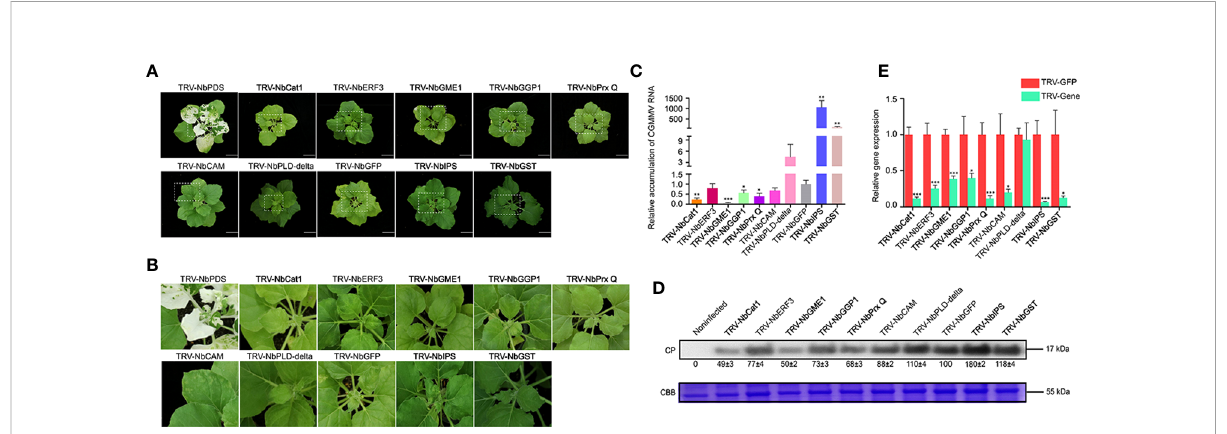
FIGURE 7 Functional analyses of nine ROS-related ggenes were determined to CGMMV infection through TRV-based VIGS assays in N. benthamiana . (A) Disease symptoms on different gene-silenced N. benthamiana plants after CGMMV infection. (B) Close-up views of upper leaves indicated by white dash boxes in (A) . (C) CGMMV accumulations determined by RT-qPCR in different gene-silenced N. benthamiana . Asterisks indicate statistical difference between treatments, determined by the two-tailed t test (* P < 0.05, ** P < 0.01, *** P < 0.001). (D) The expression levels of CGMMV CP proteins in upper leaves of N. benthamiana . (E) Silencing ef fi ciencies of target genes determined through RT-qPCR. Asterisks indicate statistical difference between treatments, determined by the two-tailed t test (* P < 0.05, ** P < 0.01, *** P <